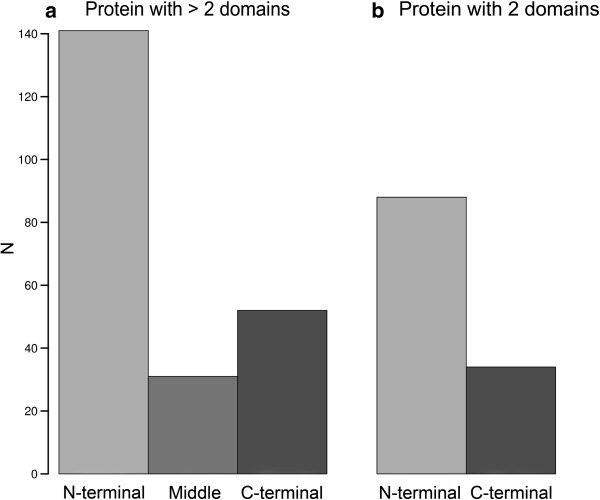
Relative position of the vertebrate domain in proteins combining old and vertebrate domains. a. Proteins containing more than 2 domains. b. Proteins containing 2 domains.